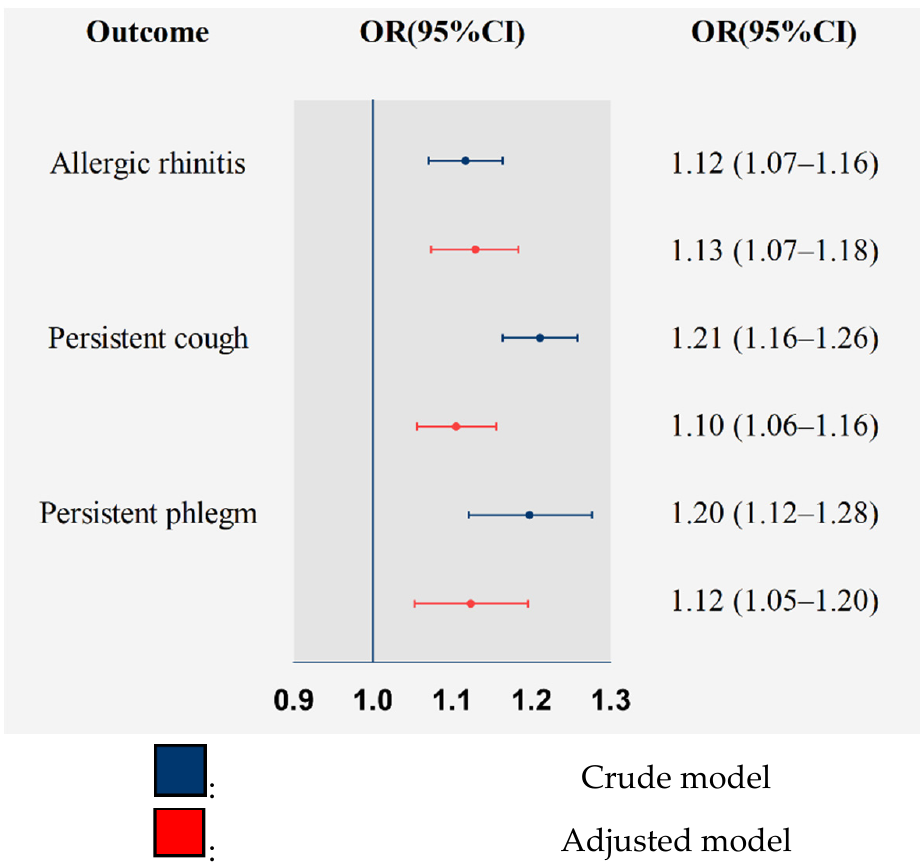
Figure 2. General linear mixed model regression analyses of doctor-diagnosed AR (3186 cases and 56,568 controls), Persistent phlegm (1865 cases and 57,889 controls) and Persistent cough (4004 cases and 55,750 controls) in relation to O 3 exposure.